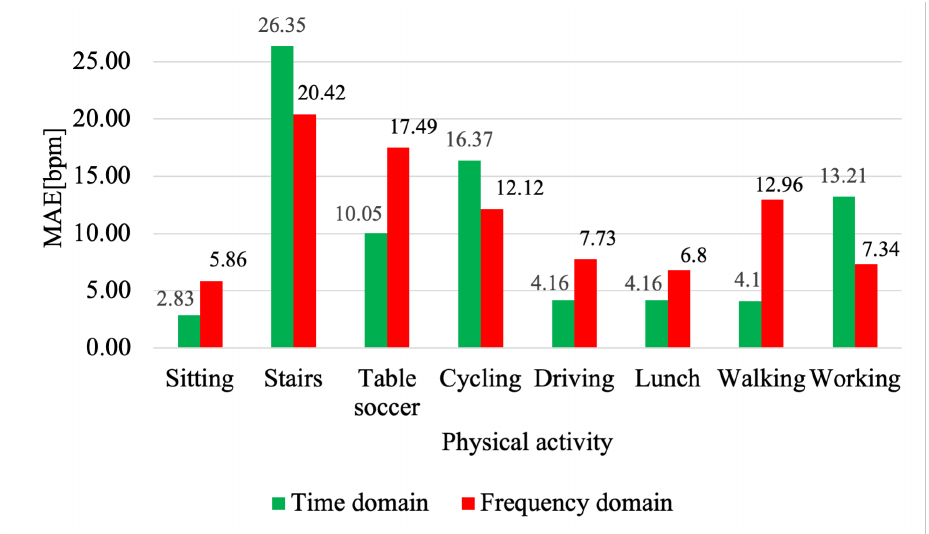
Figure 5. Comparison of average activity scores for different methods of data